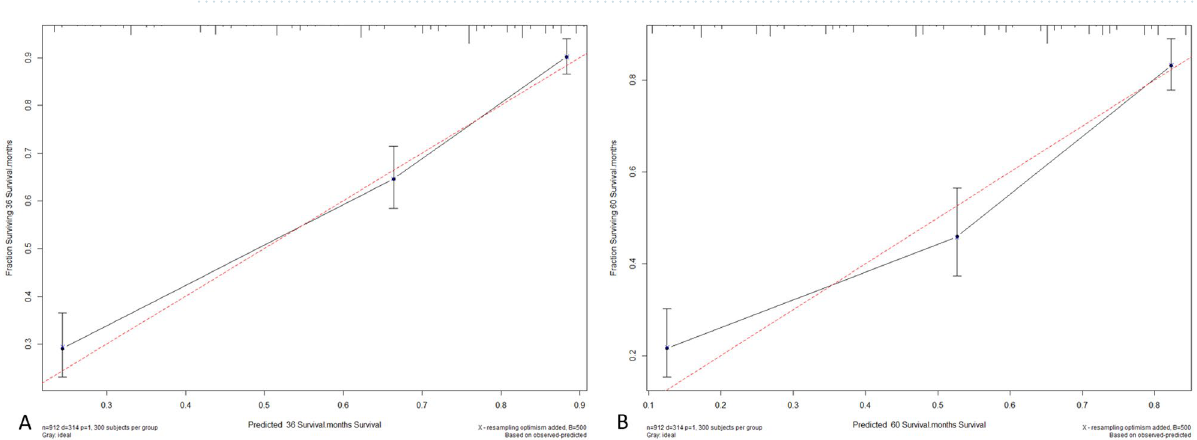
Figure 3. 3- ( A ) and 5-years ( B ) calibration curves for probability of HCC patient CSS nomogram construction in training cohort (bootstrap = 500 repetitions).